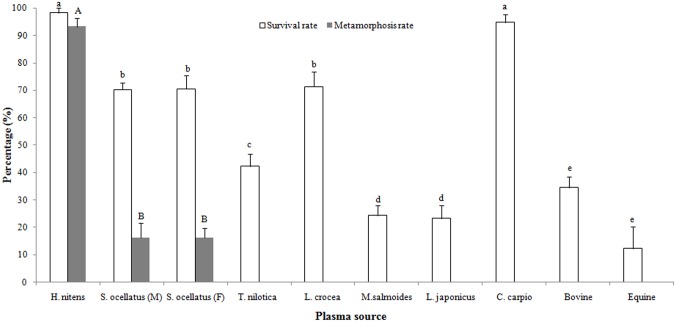
Percentage of survival and transformation of glochidia of pink heelsplitter in vitro culture with addition of 9 kinds of plasma respectively.